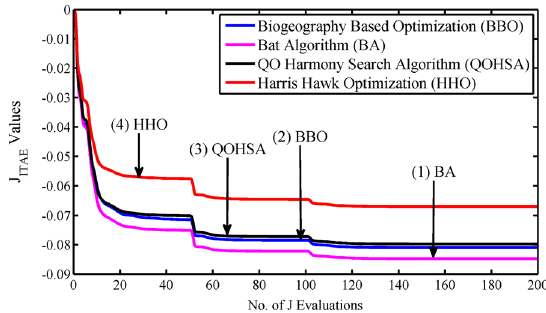
Fig. 8 Convergence characteristics of HHO with BA, QOHSA and